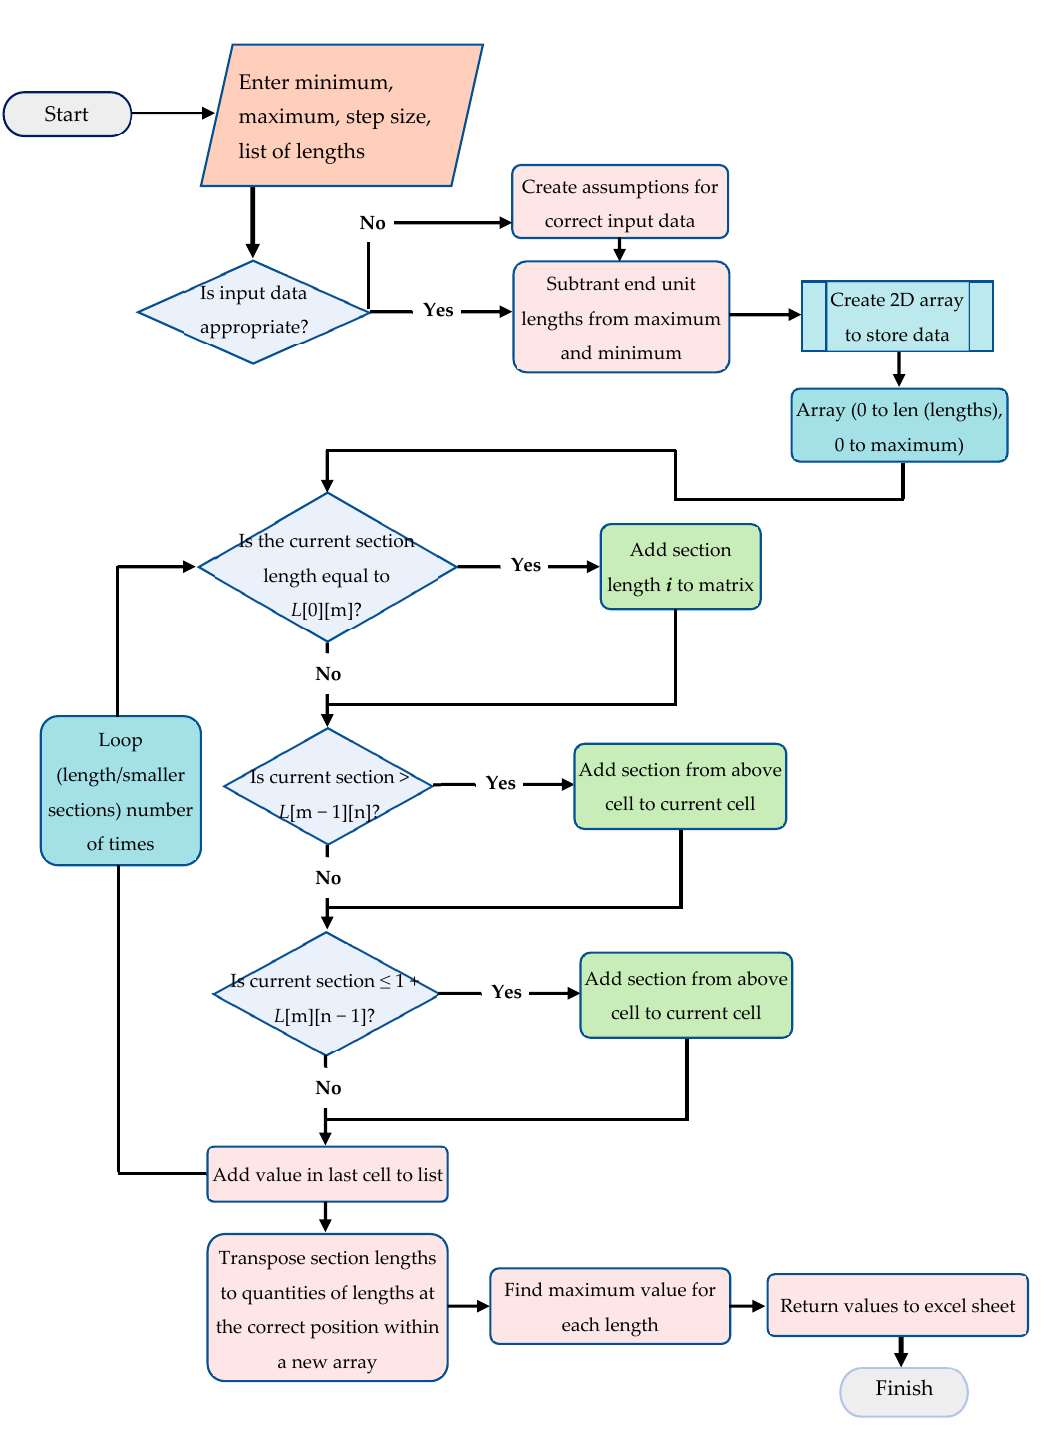
Figure 3. Operating procedures of the algorithm.